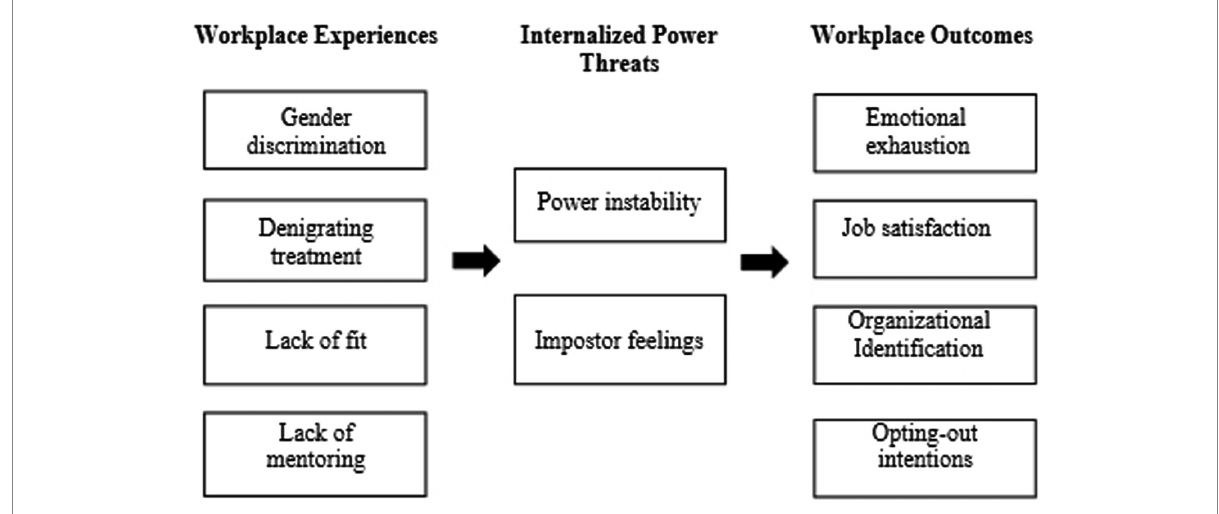
FIGURE 1 Conceptual model of workplace experiences, internalized power threats, and workplace outcomes. The constructs outlined in the figure are illustrative of the overarching factors of workplace experiences and workplace